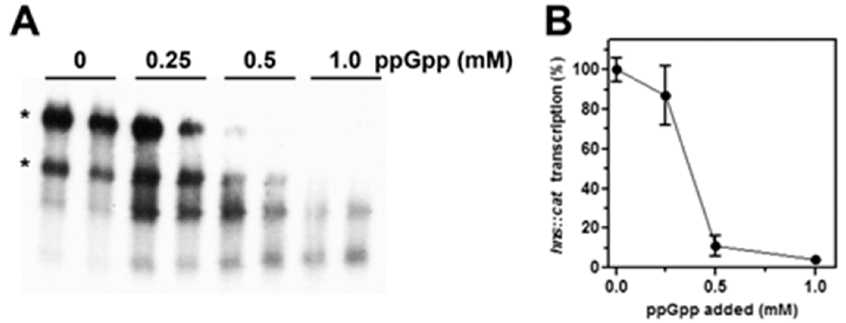
Figure 4. (p)ppGpp represses the in vitro transcription of hns . The activity of hns promoter was investigated by an in vitro assay as a function of increasing concentrations of (p)ppGpp. The supercoiled plasmid pKK400:: cat (~100 ng ) used as DNA template was incubated for 10 min at 37 °C with the E. coli RNA polymerase and the indicated amounts of (p)ppGpp. Then, transcription was stopped, and RNA analyzed by northern blot hybridized with a [ 32 P]-labeled cat probe obtained from pCM7 (Pharmacia) ( A ). Asterisks indicate the two cat mRNAs that start from the hns promoter and end at the rrnB ribosomal RNA T1 or T2 terminators located downstream cat gene on pKK400. Transcription is expressed as percentage (%) taking the mRNA level in absence of (p)ppGpp as 100% ( B ). Reactions and processing of samples are described in detail in Materials and Methods. A representative gel is shown, and data correspond to the average of two independent experiments with duplicated points and standard deviation.